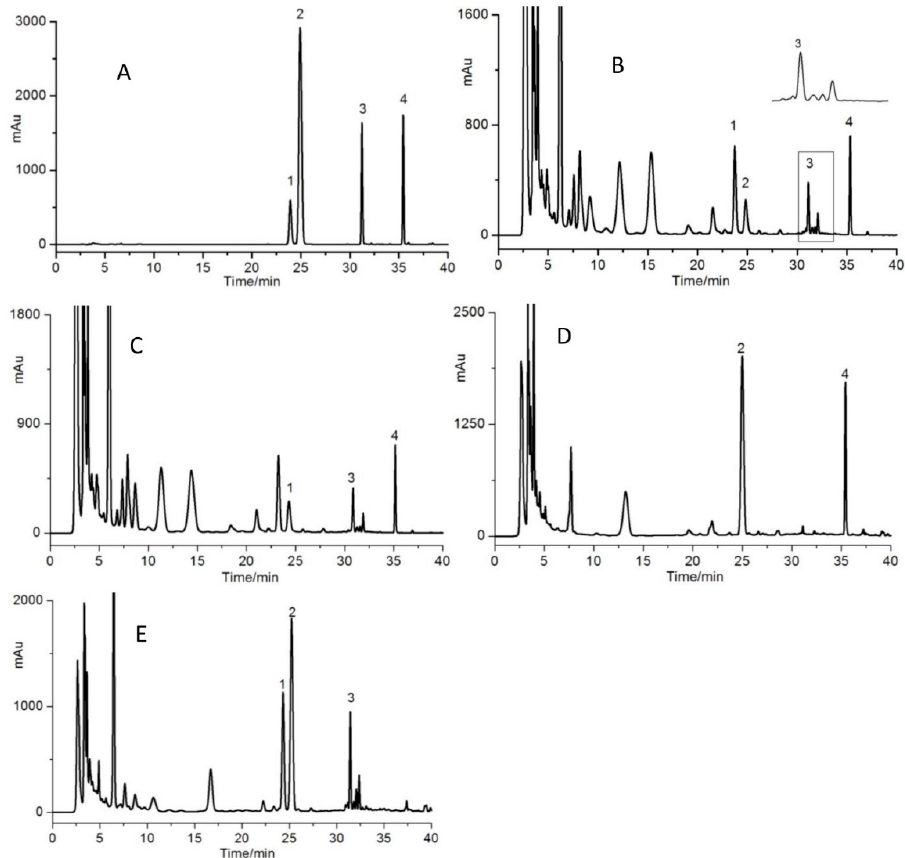
Figure 2. HPLC chromatographic profiles of standards mixture ( A ); sample of Hu–gan–kang–yuan capsule ( B ); negative control sample without Moutan cortex ( C ); without Scutellariae radix ( D ); and without Polygoni cuspidate rhizome et radix ( E ). 1: baicalein, 2: paeonol, 3: wogonin, 4: emodin.